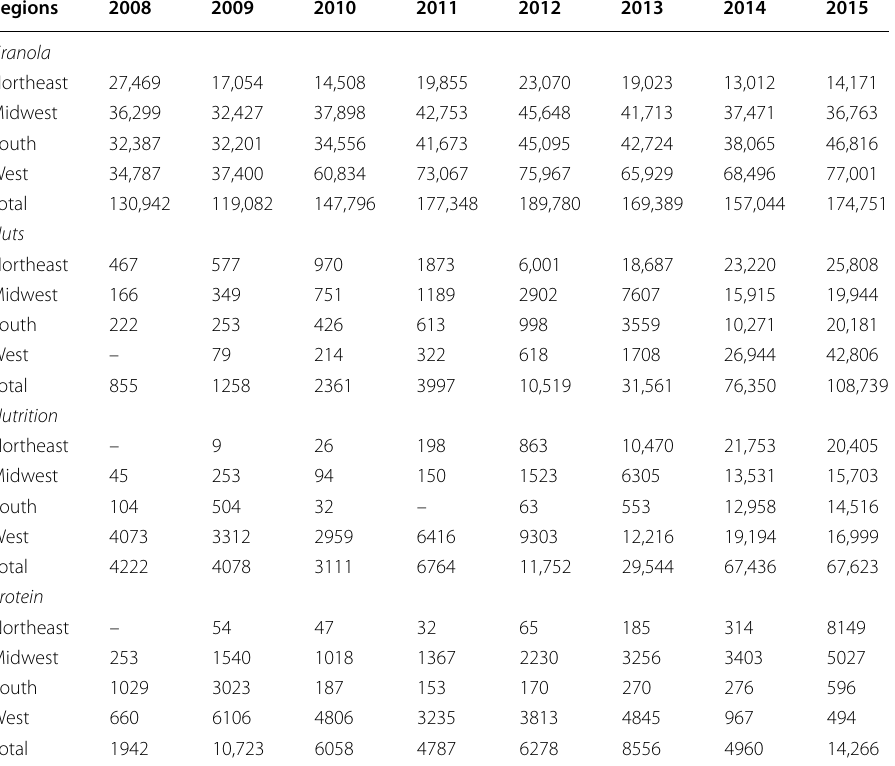
Table 1 The quantity of hemp products sold by region in the USA